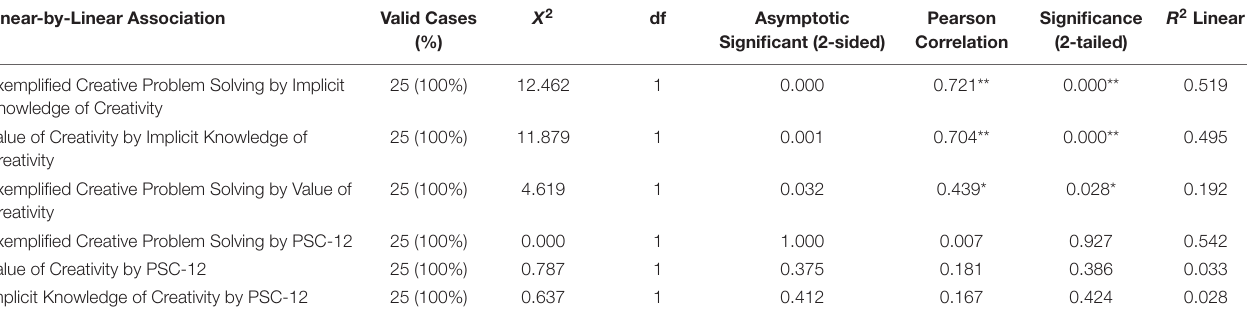
TABLE 6 | Mantel-Haenszel Test of Trend for liner associations between exemplified creative problem solving, implicit knowledge of creativity, value of creativity, and PSC-12. Linear-by-Linear Association Valid Cases